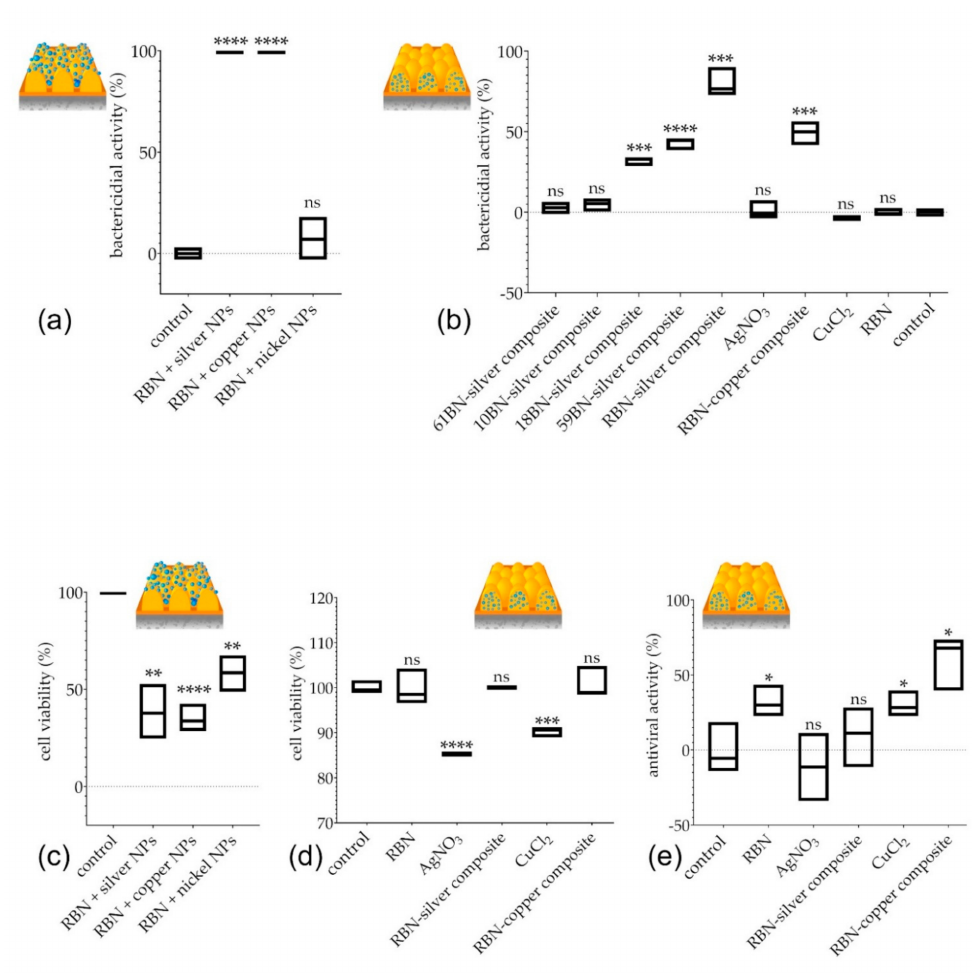
Figure 6. Bactericidal, antiviral, and cytotoxic properties of diverse metalized nanocoatings. ( a ) Met- allization on top of pre-formed Retinin-based nanocoatings (RBN) completely eliminated bacteria, when containing silver or copper (but not nickel) nanoparticles (NPs). ( b ) Metallization, before formation of nanocoatings, provided high bactericidal activity, when Retinin-based nanocoatings (RBN) were built together with silver and copper composites. Silver composites with nanocoat- ings, based on Retinin-like proteins CG42718 and CG13059 (18BN-silver and 59BN-silver in the figure), were, also, bactericidal, unlike those based on Nplp3 (61BN-silver) or CPR10 (10BN-silver). Non-metalized RBN, as well as surface treatment with metallic salts alone, were ineffective. ( c , d ) Met- allization on top of pre-formed Retinin-based nanocoatings (RBN) resulted in significant cytotoxicity ( c ), unlike metallization before formation of the nanocoatings ( d ). Note, different Y-axis scales in ( c , d ). ( e ) Antiviral properties of metalized bionic nanocoatings. Data are presented as mean ± SD, n = 3; “ns” indicates absence of significant difference, * indicates the p -value ≤ 0.05, ** indicates the p -value ≤ 0.01, *** p -value ≤ 0.001, **** p -value ≤